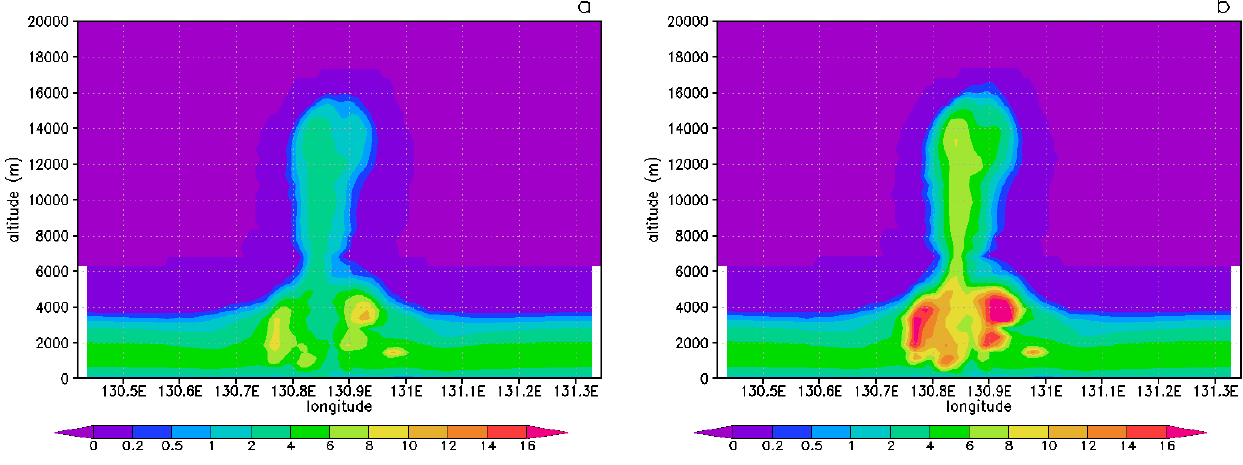
Fig. 10. Same as Fig. 9 but for t 0 + Figure 10: Same as Fig. 9 but for t